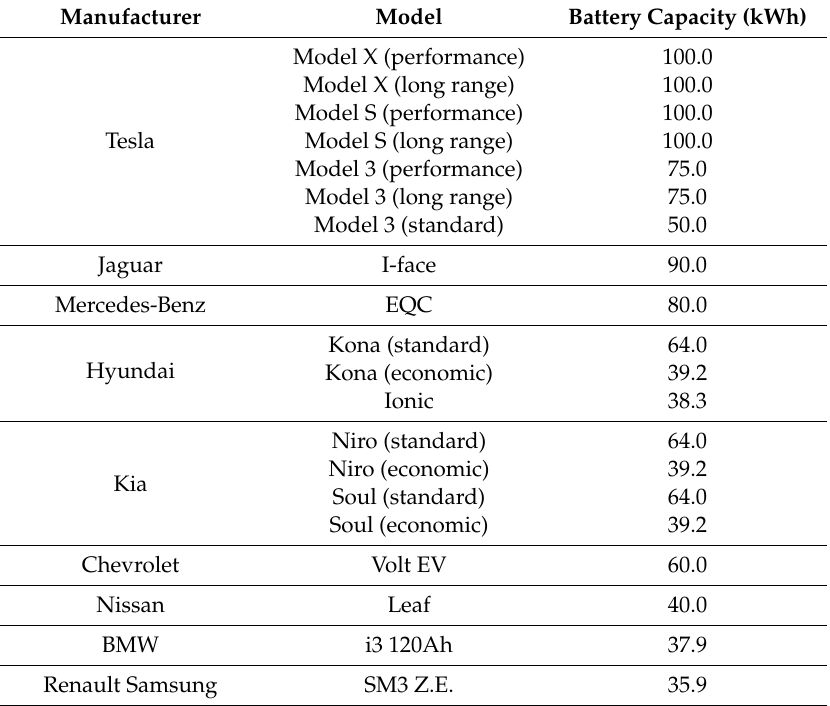
Table A1. Existing EVs and their battery